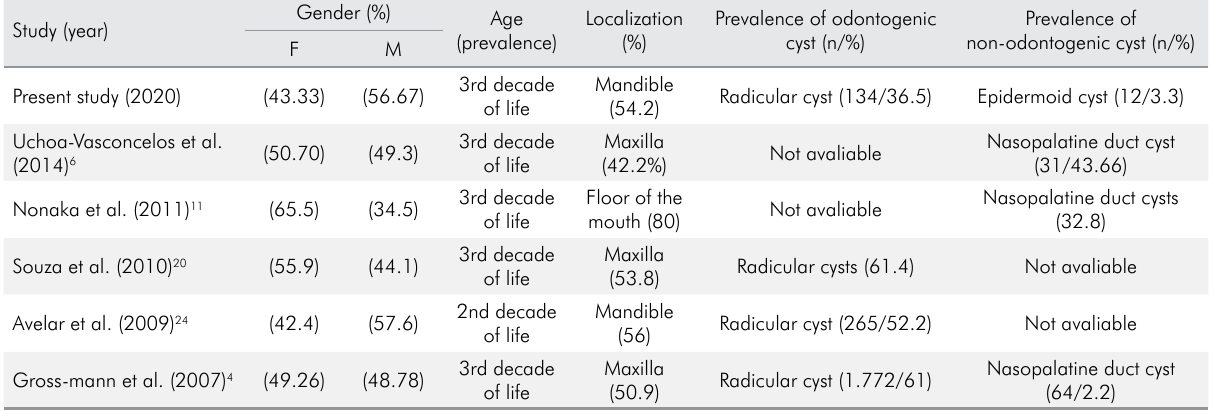
Table 4. Distribution of odontogenic and non-odontogenic cysts from the present study and selected references in Brazilian